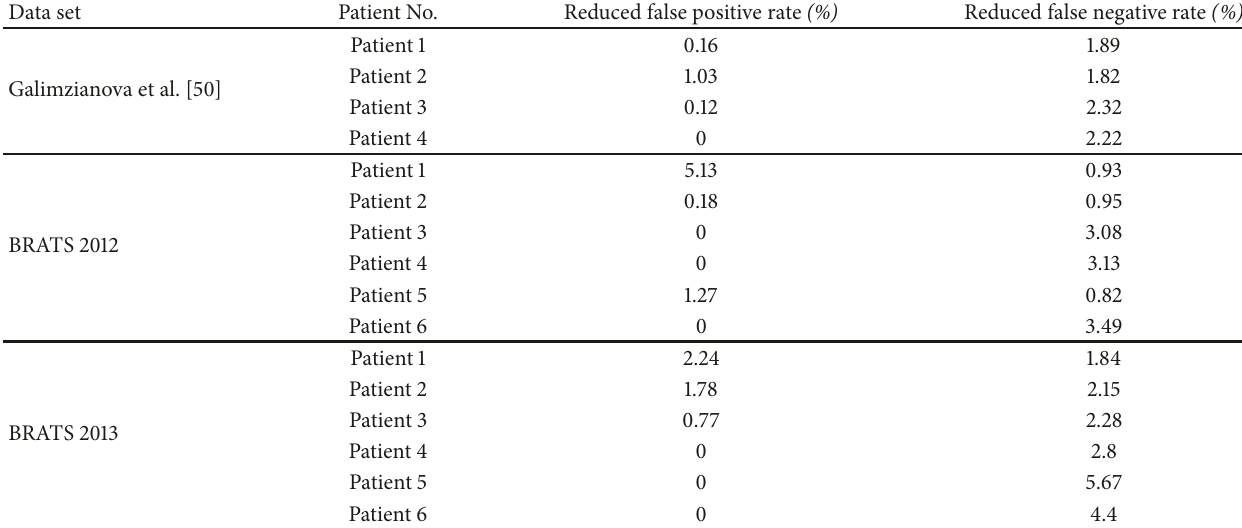
Table 7: The percent of tumor and healthy areas differentiated by segmentation in thermal images only. Data set Patient